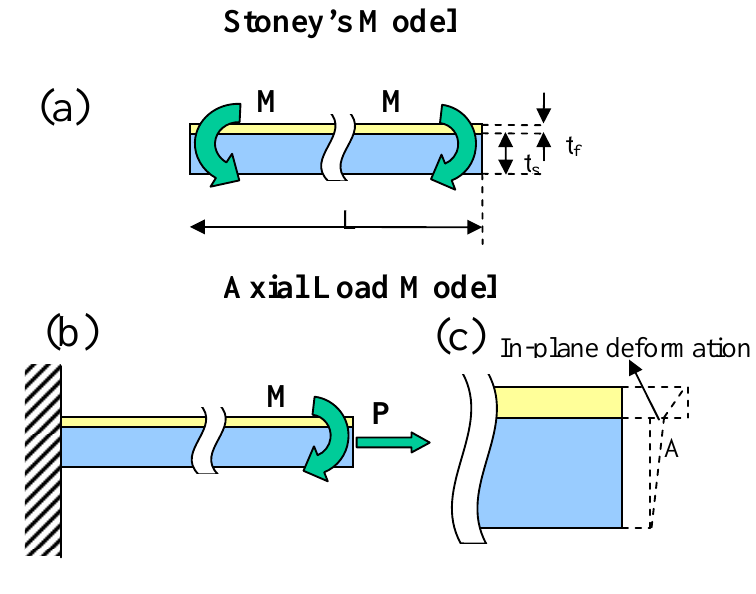
Figure 1 . Scheme of (a) the Stoney’s model for a plate deformation. The strain is derived from a moment applied at the free end of the cantilever. (b) the axial load model. An axial load component is added to take in account the effect of the clamping and also (c) the force induced by the displacement of the layer at the